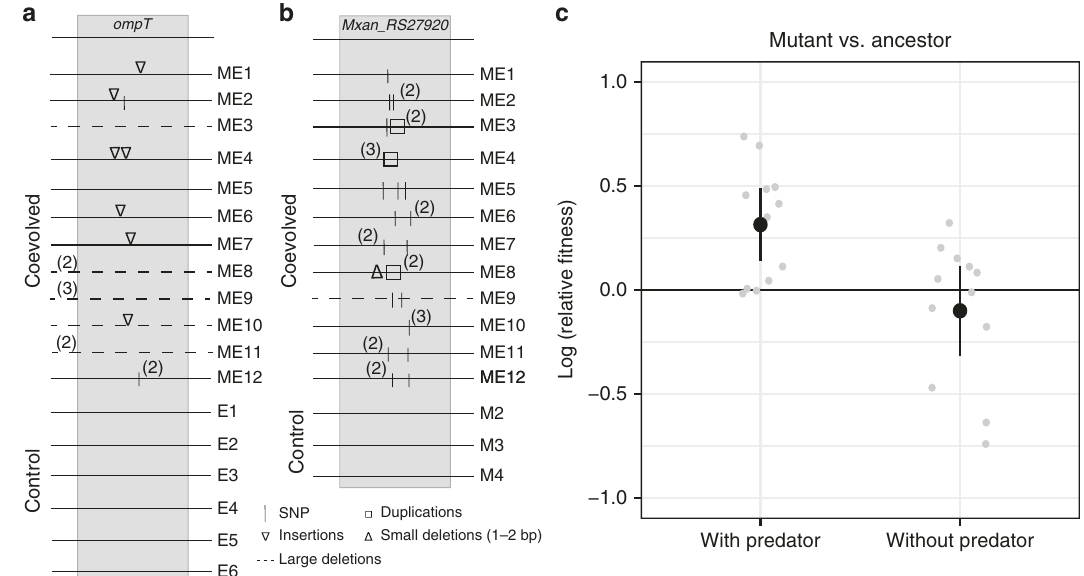
Fig. 3 Parallel genomic evolution reveals adaptation speci fi c to the coevolution treatment. a Parallel mutation of ompT among coevolved prey populations. b Parallel mutation of Mxan_RS27920 among coevolved predator populations. a , b Numbers in parentheses indicate the number of sampled clones (of three) in a population sharing the adjacent mutation. c Fitness of an ompT -deletion mutant in competition with the ompT + ancestor in the presence and absence of the ancestral predator ( n = 6 for both treatments). Gray dots are individual data points, black dots are means and error bars represent 95% con fi dence intervals ( t -distribution). Source data are provided as a Source Data fi le E. coli